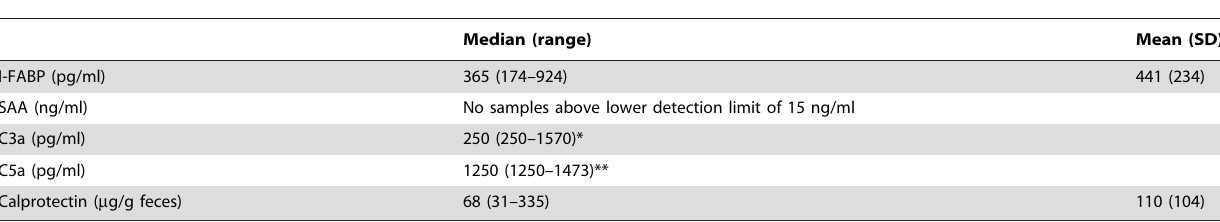
Table 5. Control values of urinary and fecal